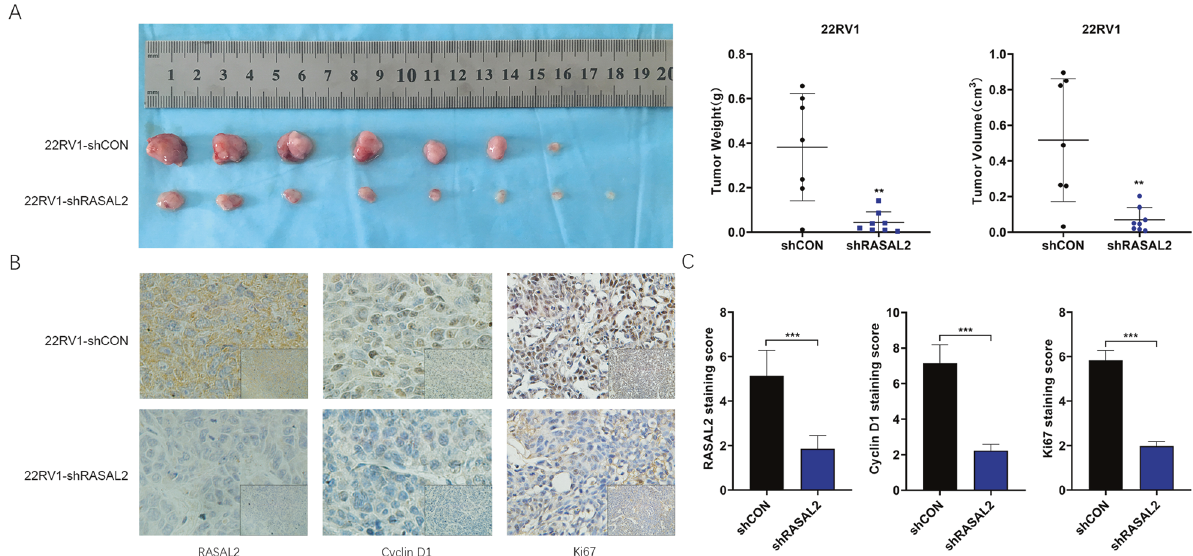
Fig. 5 RASAL2 modulates PCa tumour growth and cyclin D1 expression in vivo. A Images of the growth of subcutaneous xenografts established by control and RASAL2 knockdown cells and statistical results of tumour mass and volume. B , C Imaging and quantitative results of immunohistochemical analysis of expression levels of RASAL2, cyclin D1 and Ki67 in transplanted